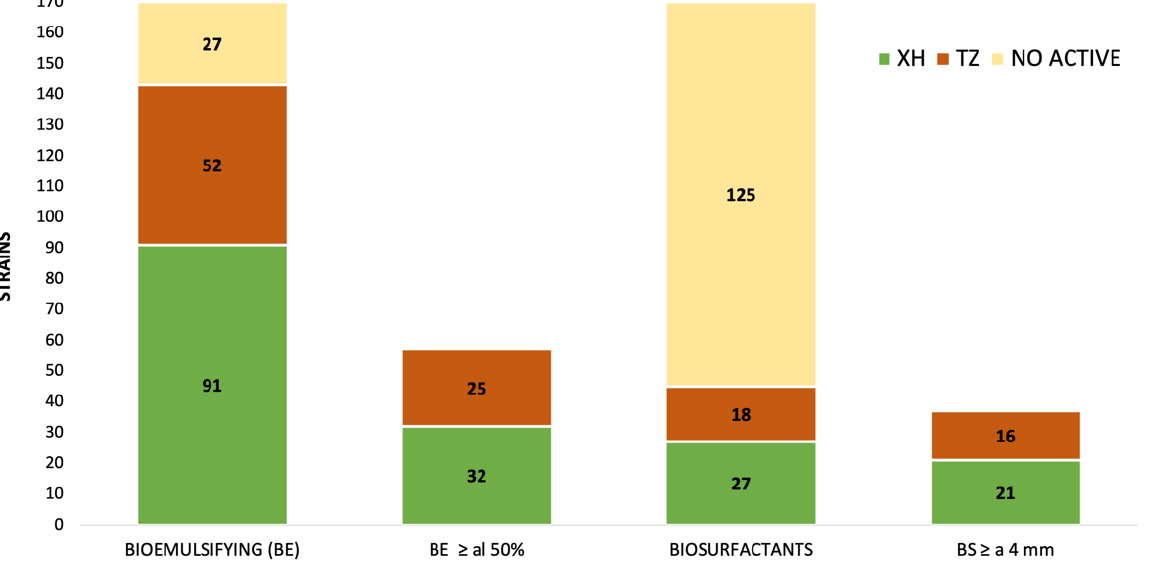
Figure 1. Bioemulsifying (BS) and biosurfactant (BS) activity, by strains isolated from the X ′ can ho che (XH) and Temozon (TZ) sinkholes and their highlighting the EI 24 ≥ 50% and drop-collapse ≥ 4 mm.